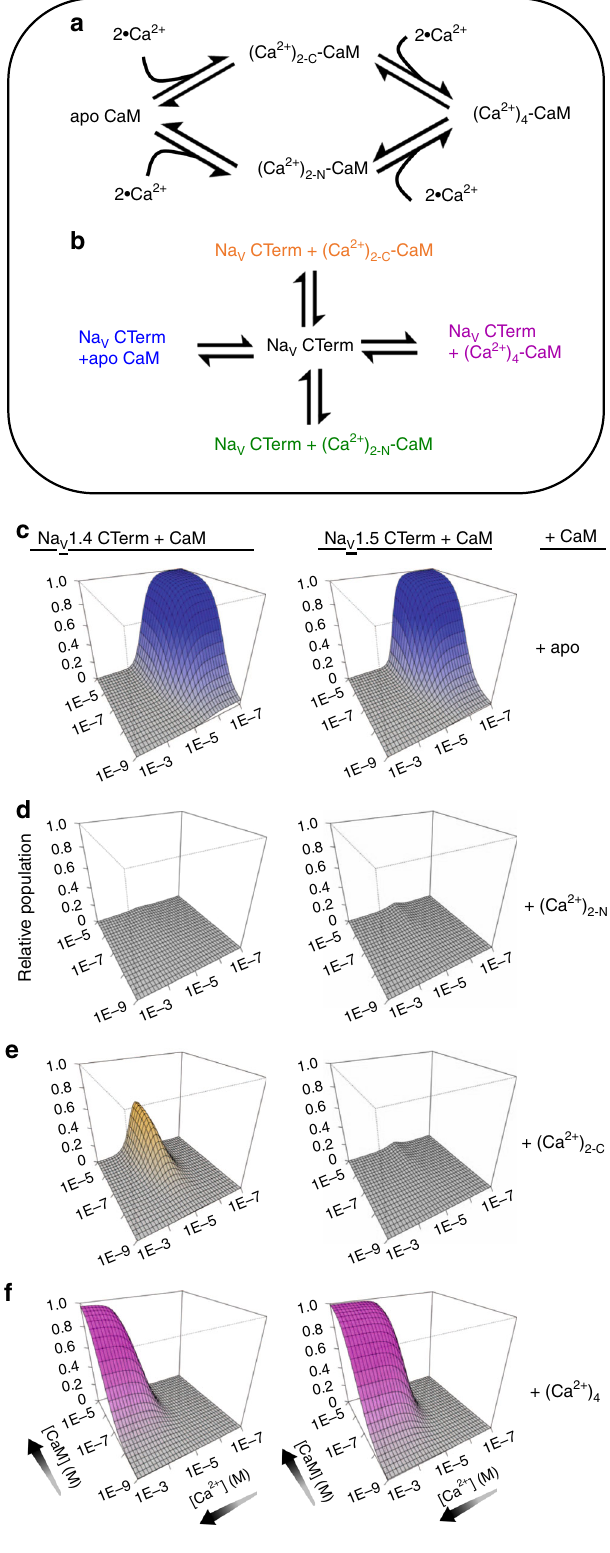
Fig. 4 Na V 1.4 CTerm and Na V 1.5 CTerm populations with bound CaM. a Reaction scheme of Ca 2 + ions binding to CaM lobes. Thermodynamic data of these binding reactions were reported previously 18, 19 . b Reaction scheme of CaM in four Ca 2 + -saturation states binding to Na V